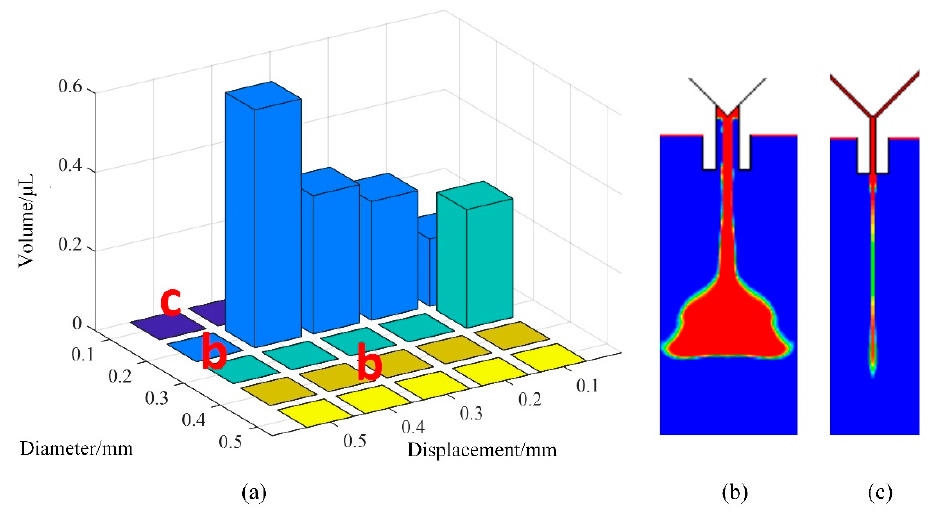
Figure 12. The influence of needle travel and nozzle diameter on droplet volume and morphology: ( a ) Jetting volume; ( b ) sputtering; ( c ) residual liquid. Conditions: The driving pressure is 0.6 MPa, the viscosity is 0.8 Pa·s, the frequency is 20 Hz, and the surface tension is 0.06 N/m.